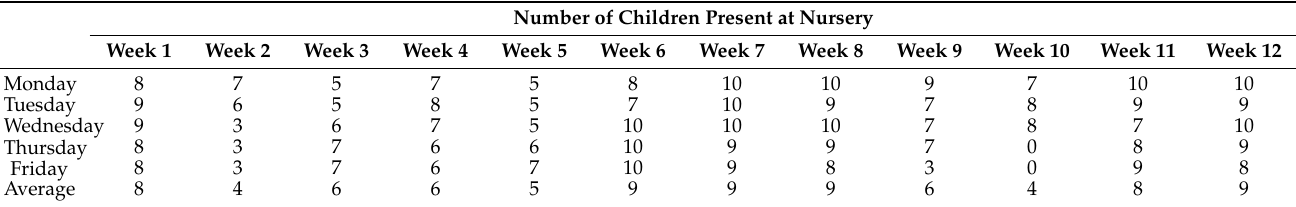
Table 5. Number of children present during the 12 weeks of measurement. Number of Children Present at Nursery